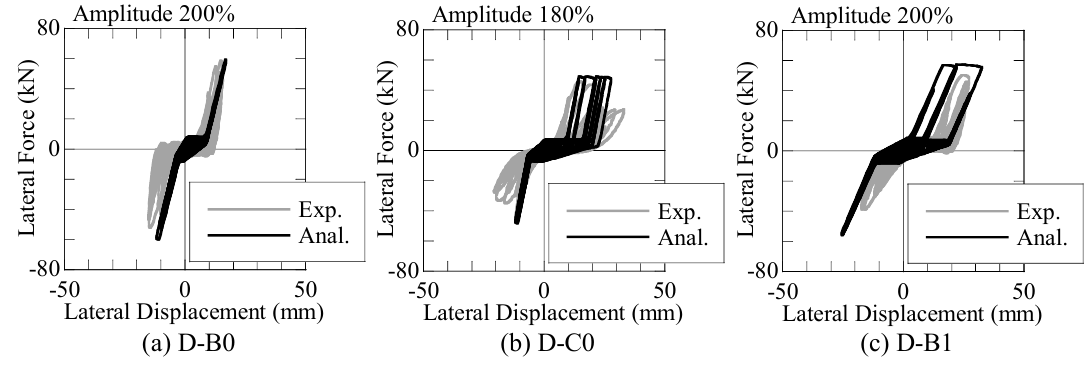
Figure 13. Analytical results based on the nonlinear